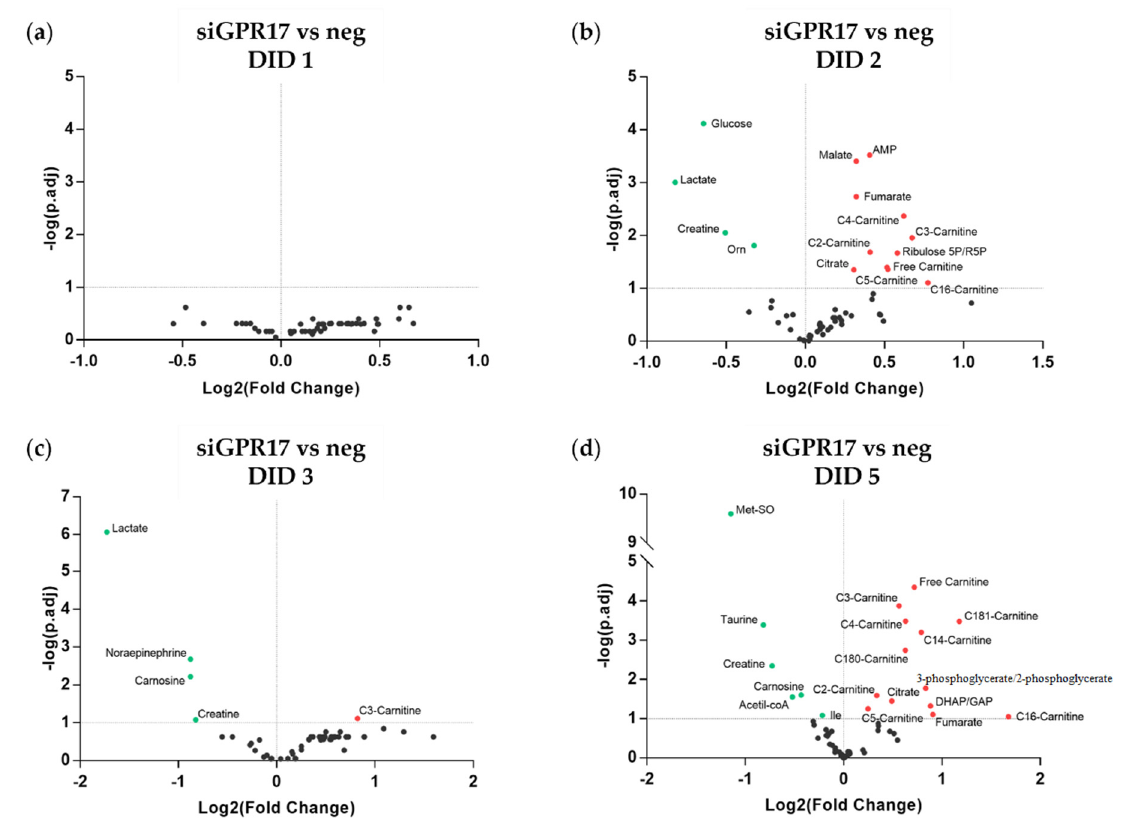
Figure 5. Metabolomic changes induced by GPR17 silencing in OPCs. ( a – d ) The abundance of each metabolite after GPR17 silencing has been normalized to that in the relative control sample. The resulting fold changes were used to generate a volcano plot for each time point (1, 2, 3, 5 days in differentiation). The points over the dotted horizontal line represent the metabolites that have shown a statistically significant change (Fisher’s LSD corrected by FDR; p.adj < 0.1). In green, metabolites with lower expression, in red, those with higher expression, after GPR17 silencing. n = 7–9 per each group. DID: days in